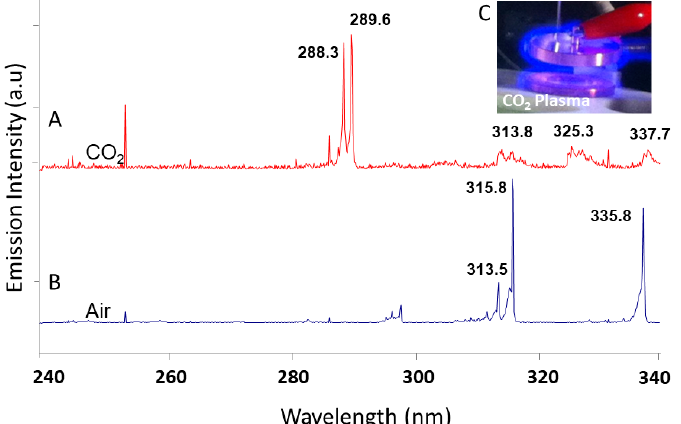
Figure 7. Emission spectra of CO 2 ( A ) and air ( B ) under low gas pressures (300 Pa); photographs of plasma excited between two plate electrodes ( C ).